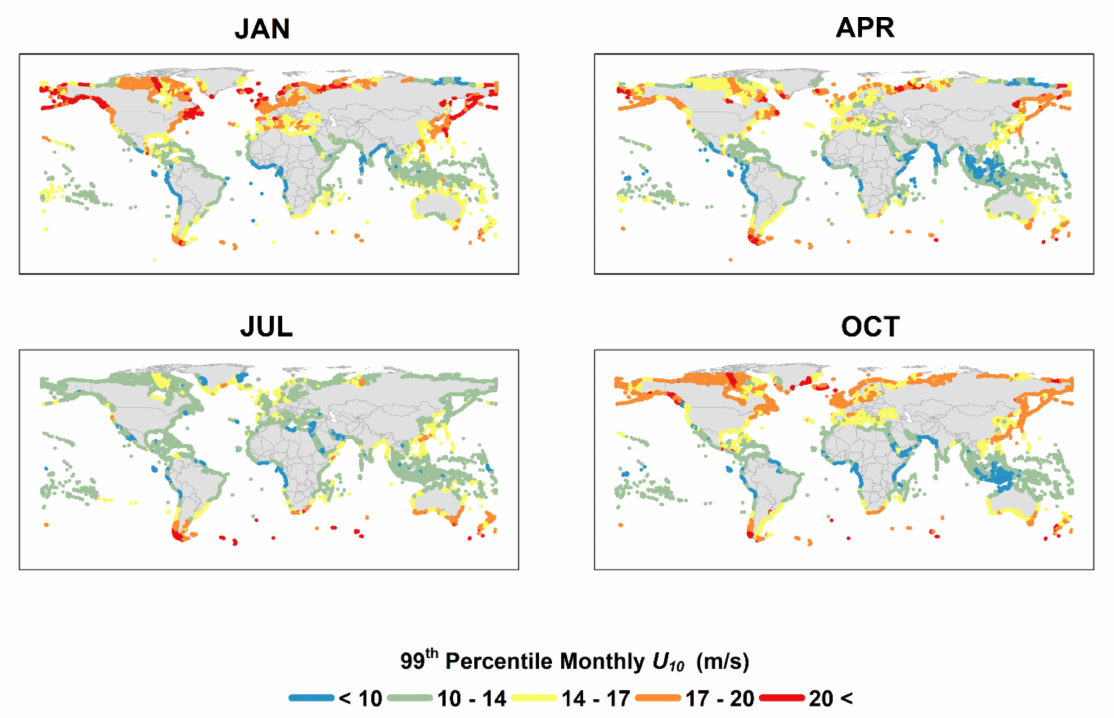
Figure 6. The 99th percentile monthly wind speed at a reference elevation of 10 m ( U 10 ), U 10 ( 99 ) at near-coastal locations defined by the DIVA